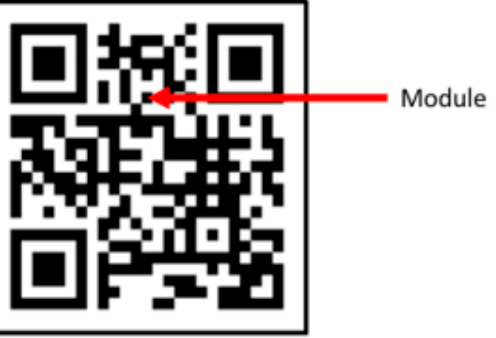
Figure 1. QR code basic unit diagram.